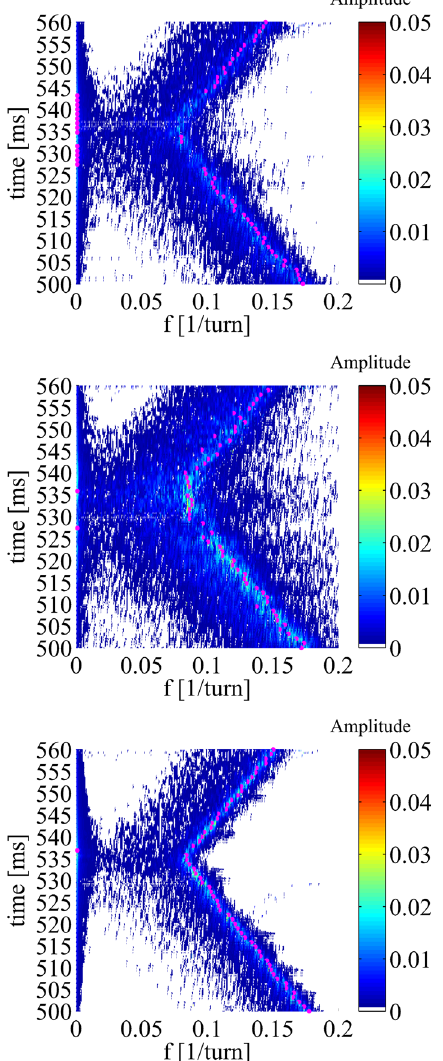
FIG. 25. Vertical coherent tunes simulations with COD cor- rection. From bottom to top the following space charge modules have been used: vertical boundaries (cid:2) 40 mm; vertical boundaries (cid:2) 29 . 5 mm; direct space charge. The magenta dots represent the peaks in the FFT of the first order